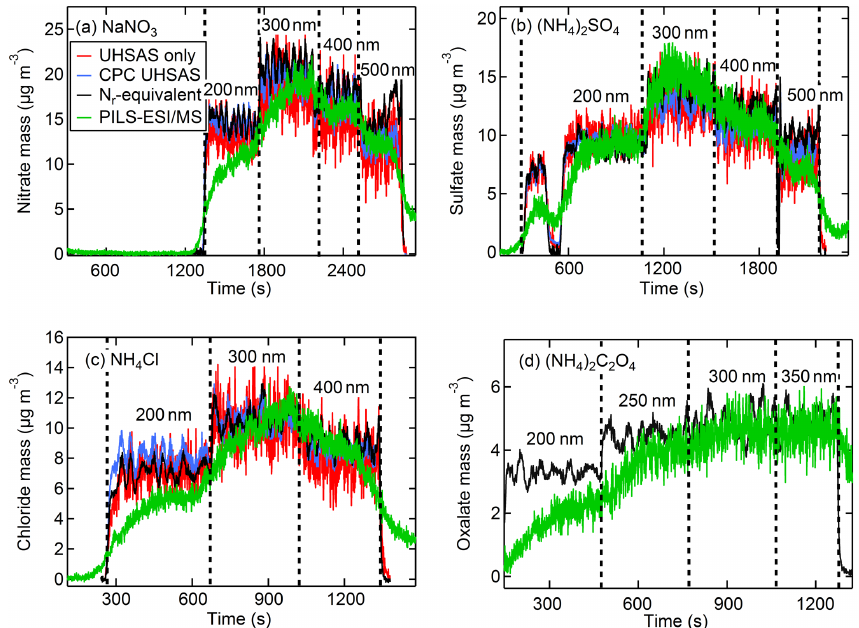
Figure 10. The N r -measured (black) CPC number with UHSAS size (blue) calculated, UHSAS number and size (red) calculated, and PILS– ESI/MS-measured (green) aerosol concentrations (µgm − 3 ) for anions of DMA size-selected aerosol for salts of (a) NaNO 3 , (b) ( NH 4 ) 2 SO 4 , (c) NH 4 Cl, and (d) ( NH 4 ) 2 C 2 O 4 . The PILS–ESI/MS traces were shifted in time several minutes early to account for the delayed instrument response